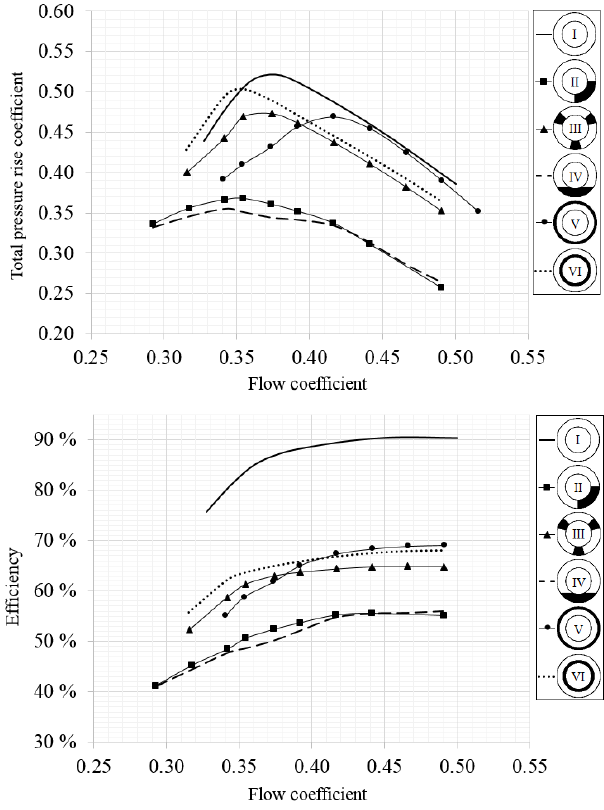
Figure 8. Performance curves for different